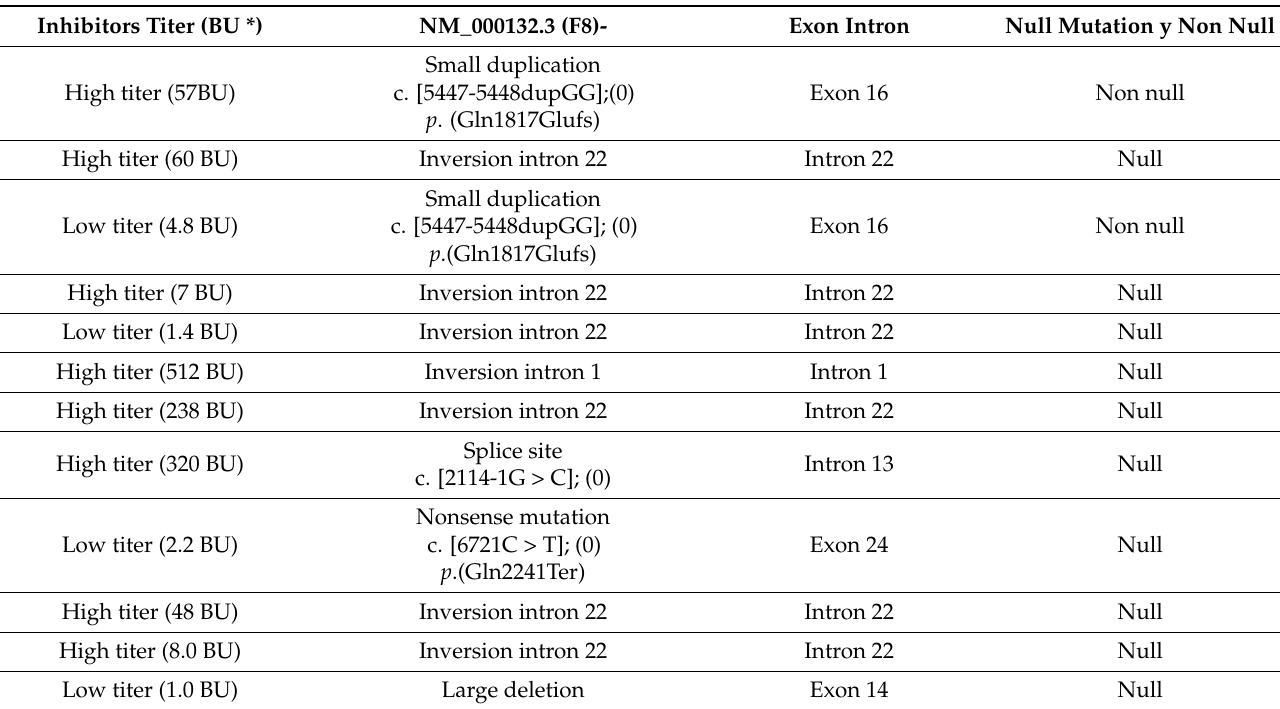
Table 2. Inhibitor titers and mutations.